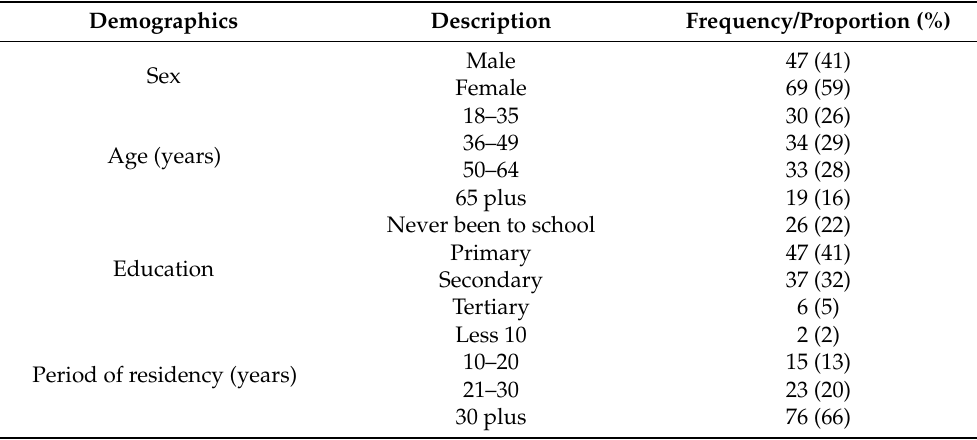
Table 2. Demographics of the respondents in Malapati, Chiredzi